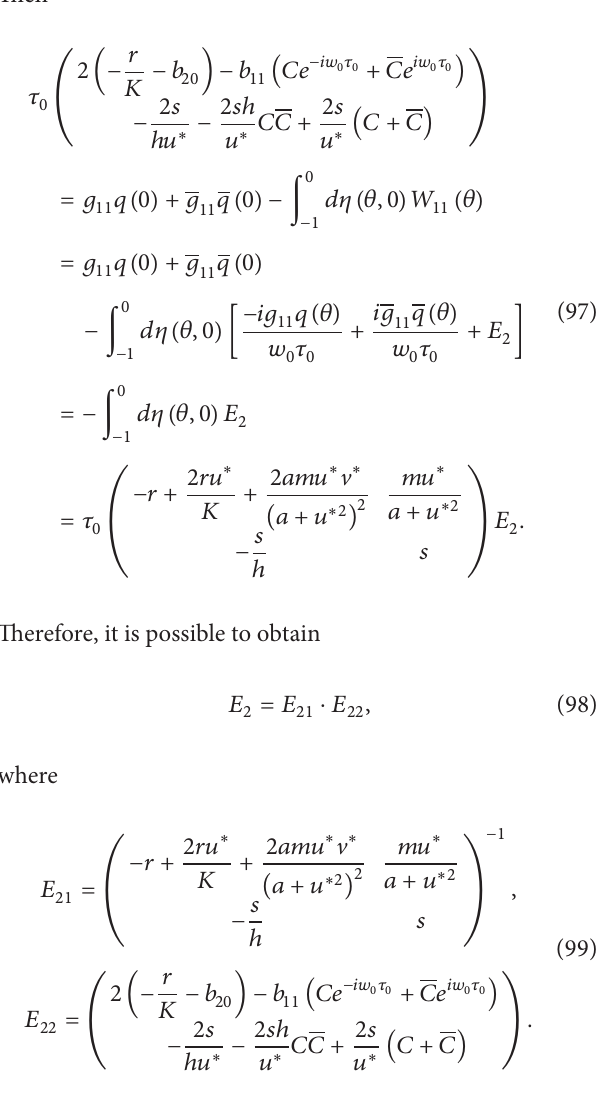
Figure 1: Convergence to positive equilibrium. Here the parameters are assumed to be 𝜏 1 = 0 , 𝜏 2 = 1.5 , and the initial values are 𝑢(𝑥,𝑡) = 0.1 + 0.01𝑡 sin 𝑥 , V (𝑥, 𝑡) = 0.5 + 0.01𝑡 cos 𝑥 , and 𝑡 ∈ [−1.5,0] , 𝑥 ∈ [0, 𝜋] .